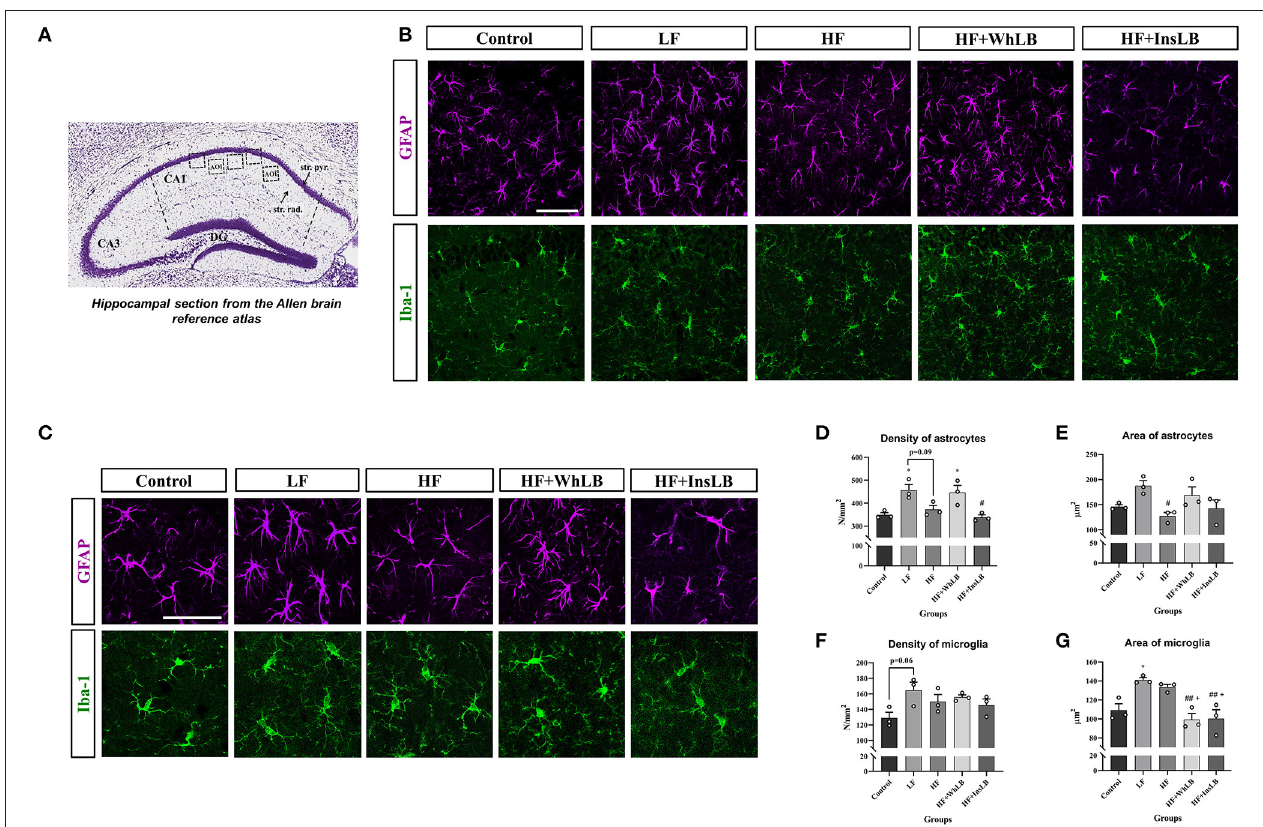
FIGURE 4 | Immunohistochemical analysis of glial cells in the hippocampal CA1 area of ApoE–/– mice. (A) The reference image of the Nissl-stained coronal section of the dorsal hippocampus obtained from the Allen Mouse Brain Atlas. Dotted line squares indicate the areas of interest (AOI) in the stratum pyramidale and stratum radiatum . (B) Immunofluorescent-labeled images of GFAP-positive astrocytes and Iba-1-positive microglia at 40x objective magnification, as well as (C) cut out and zoomed fragments (crops) from these images for better visualization of the processes and somas of astrocytes and microglial cells. (D–G) The morphometric characteristics of glial cells: (D) the density of GFAP-positive astrocytes and (E) their area; (F) the density of Iba-1-positive microglia and (G) the area of microglial cells. Data are expressed as the Mean ± SEM ( n = 3/group). Comparisons among groups were performed with the one-way ANOVA, followed by Turkey’s post hoc test. * p < 0.05 indicates significant differences vs. control; # p < 0.05 and ## p < 0.01 indicate significant differences vs. LF; + p < 0.05 indicates significant differences vs. HF. The scale bar corresponds to 50 µ